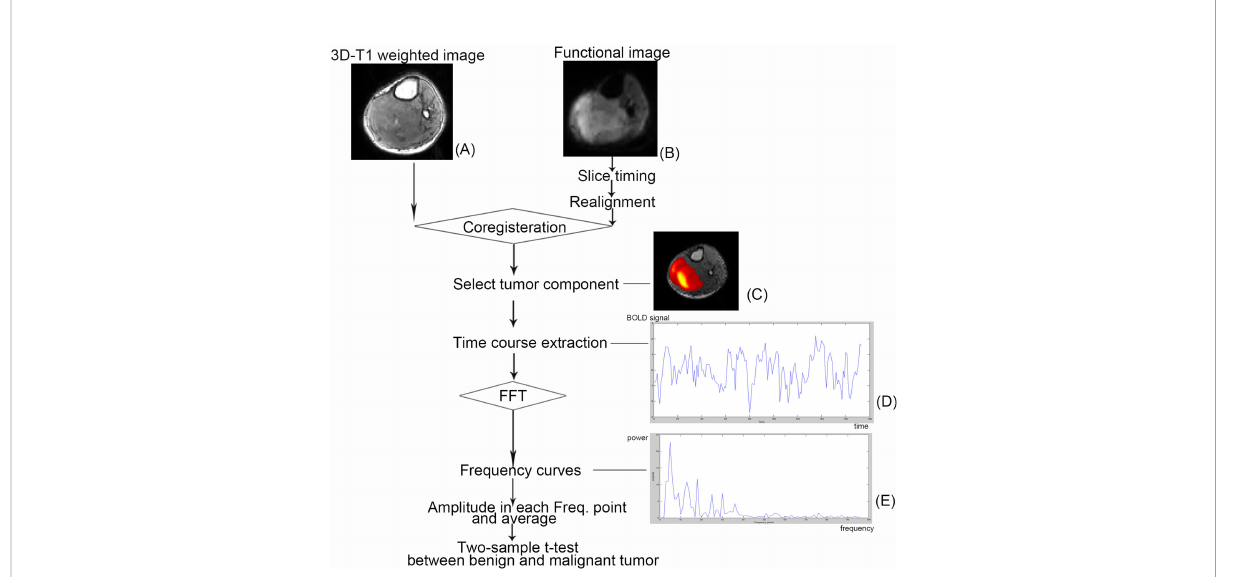
FIGURE 1 Schematic illustration of the course to data processing and analysis. The selected patient is a 57-year-old man with primitive neuroectodermal tumor in his right calf. (A) A functional image. (B) A 3D T1-weighted image. (C) The tumor component selected in independent component analysis. (D) The time course after preprocessing and independent component analysis. (E) Power spectrum using fast Fourier transformation